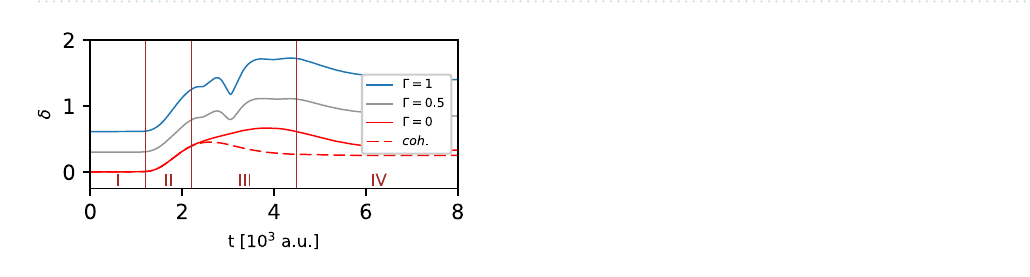
Figure 5. The spatio-temporal pattern of the probability density for the DSC-state in the presence of the potential barrier for different values of the quality parameter: ( a ) Ŵ = 0 , ( b ) Ŵ = 0.5 and ( c ) Ŵ = 1 . The vertical solid line indicates the position of the potential barrier.